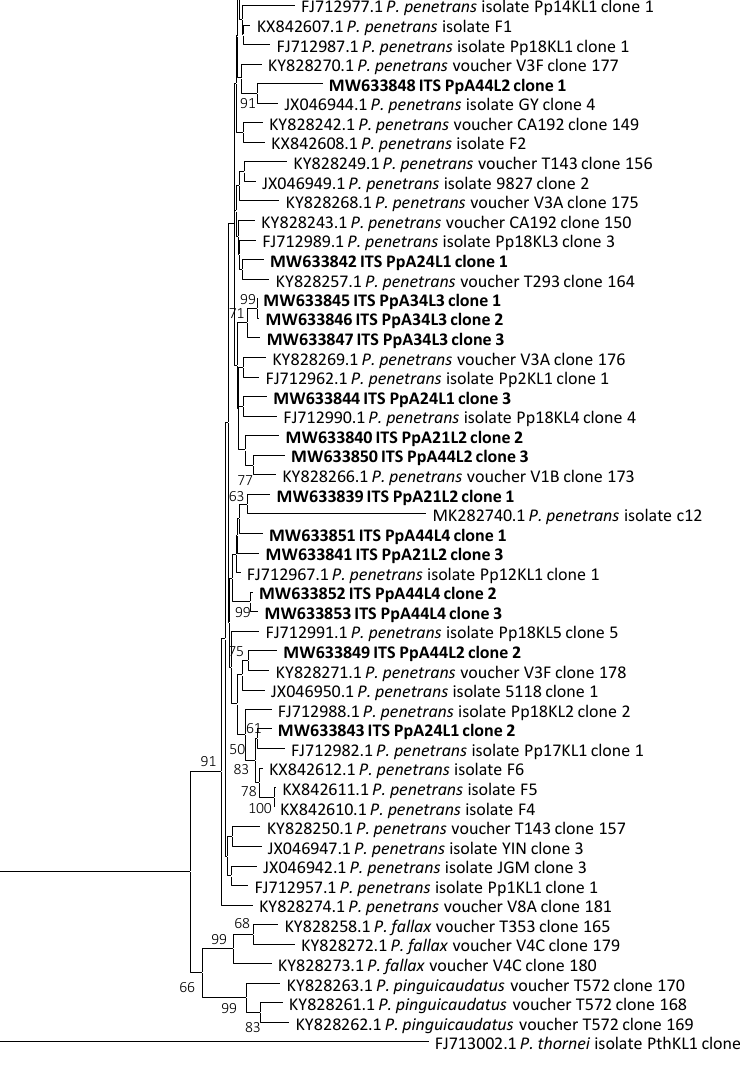
Figure 2. Neighbor-joining phylogenetic tree based on ITS nucleotide sequences of Pratylenchus penetrans , P. pinguicaudatus and P. fallax . ITS sequence from P. thornei was used as an outgroup. Bootstrap values are shown next to the branches and values with less than 50% confidence were not shown. Scale bar represents nucleotide substitutions per